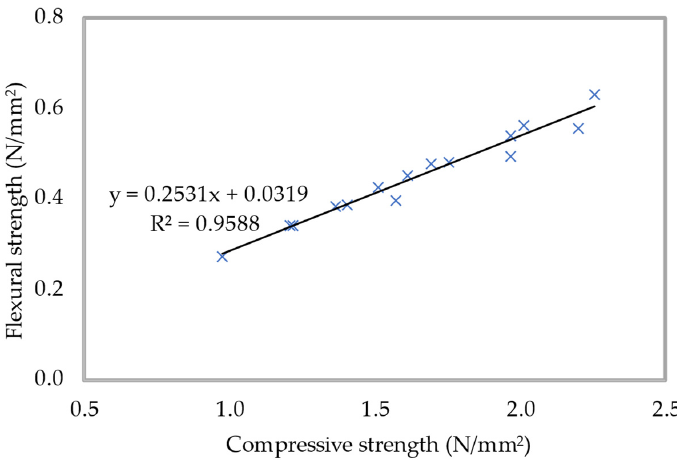
Figure 21. Compressive-tensile strengths relationship for 600 kg/m 3 density.